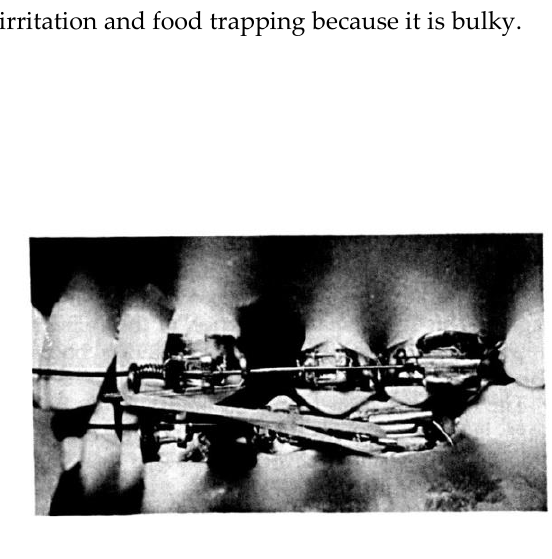
Figure (10): Canine retraction using sliding jig and elastic